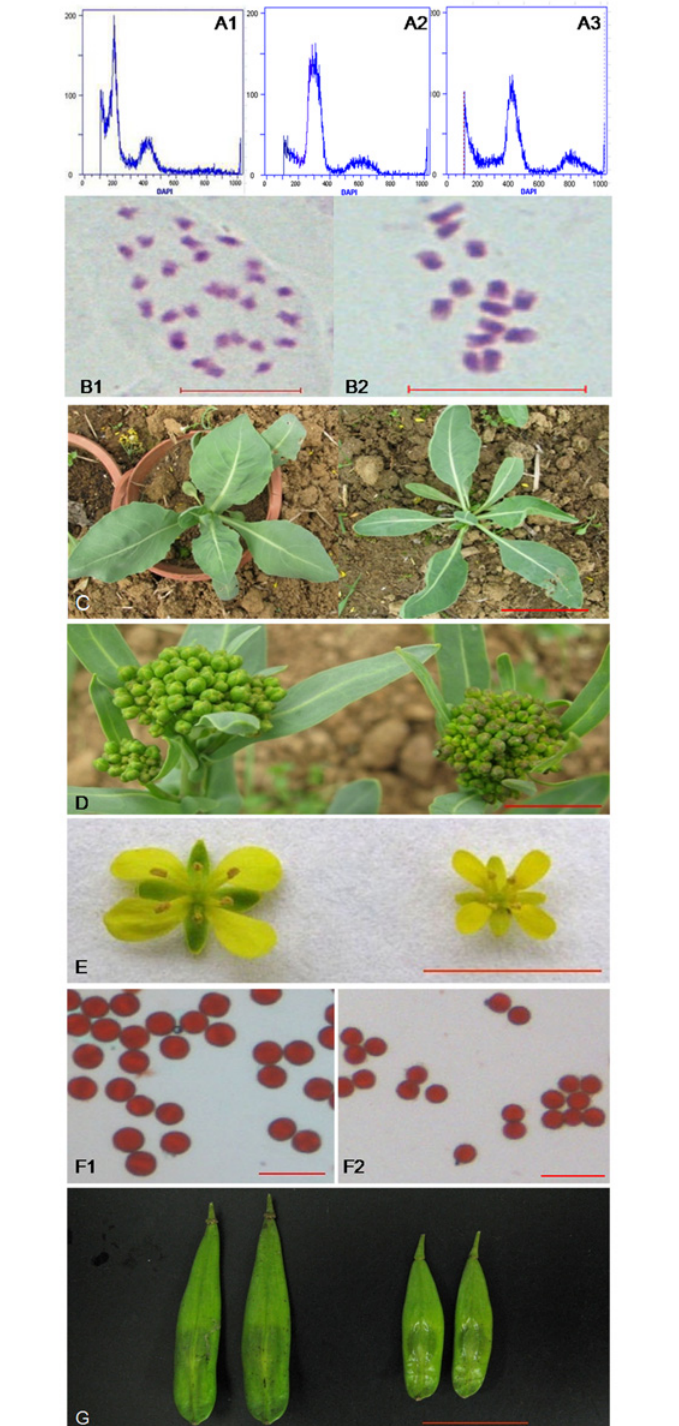
Fig 1. Ploidy analysis and phenotypic characterization of autopolyploid. A: Ploidy analysis of 2 x (A1), 3 x (A2), 4 x (A3) woad by flow cytometer. B: Mitotic metaphase of 4 x plant with 28 chromosomes (B1) and 2 x plant with 14 chromosomes (B2). C-G: Morphological differences between diploid and autotetraploid, C-G: plantlets, inflorescence, flowers, pollen grains and siliques of autotetraploid (left) and diploid (right). Scale bars: B, F = 10 μ m; C = 10 cm; D, E, G = 1 cm.